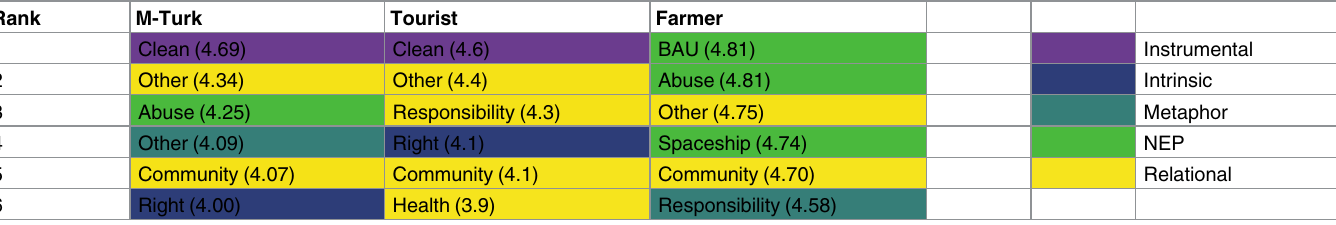
Table 5. Top six mean responsesto environmental value statements across three populations. The top four farmer scores are not statistically different from each other, effectively all beingtied for first, comm_rel is statistically different from the first two, bau_nepand abuse_nep.